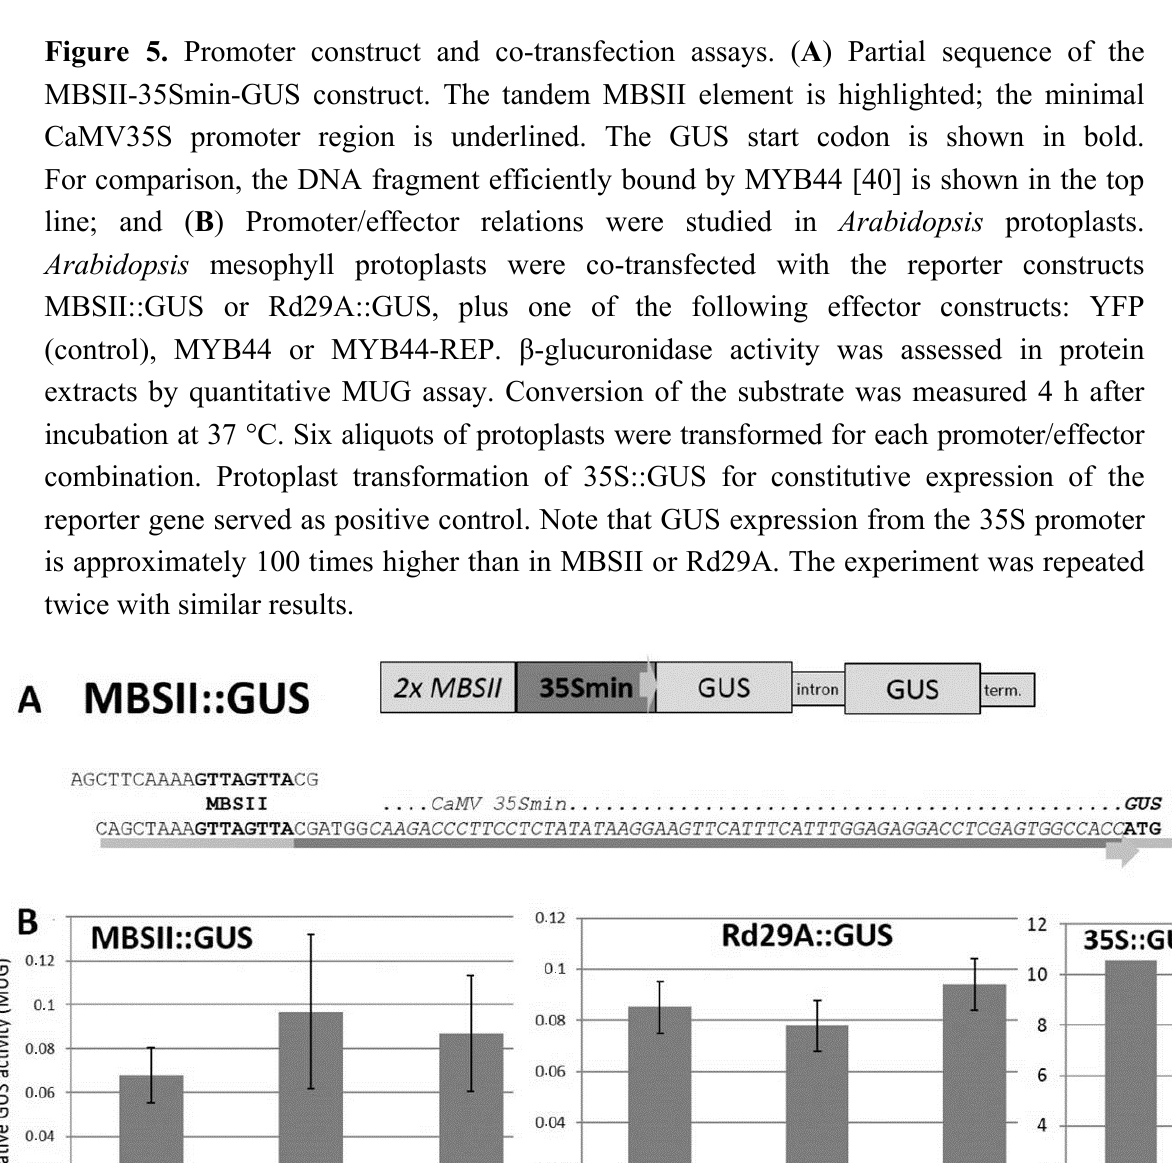
Figure 5. Promoter construct and co-transfection assays. ( A ) Partial sequence of the MBSII-35Smin-GUS construct. The tandem MBSII element is highlighted; the minimal CaMV35S promoter region is underlined. The GUS start codon is shown in bold. For comparison, the DNA fragment efficiently bound by MYB44 [40] is shown in the top line; and ( B ) Promoter/effector relations were studied in Arabidopsis protoplasts.